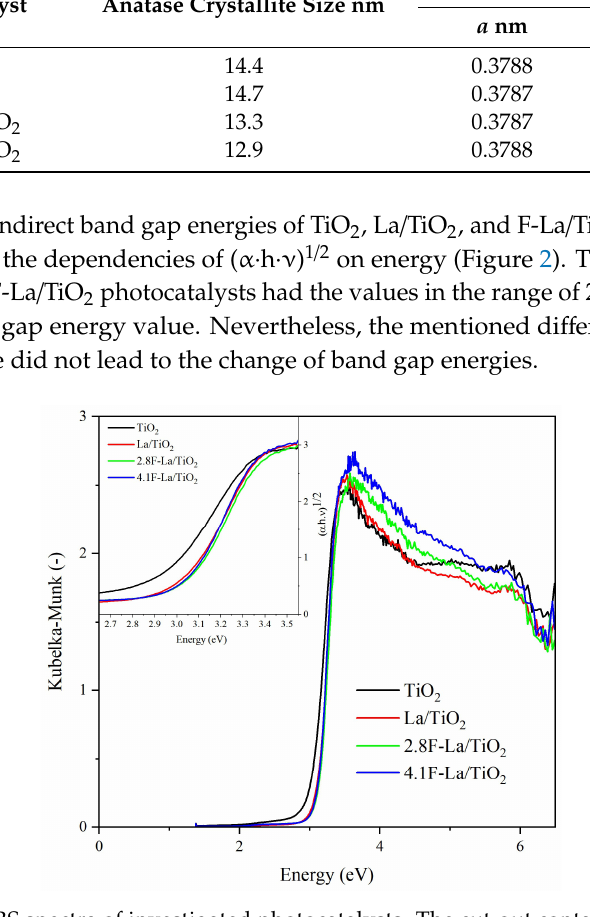
Figure 2. UV-Vis DRS spectra of investigated photocatalysts. The cut-out contains the Tauc plot and the determination of the indirect band gap energy values. the determination of the indirect band gap energy